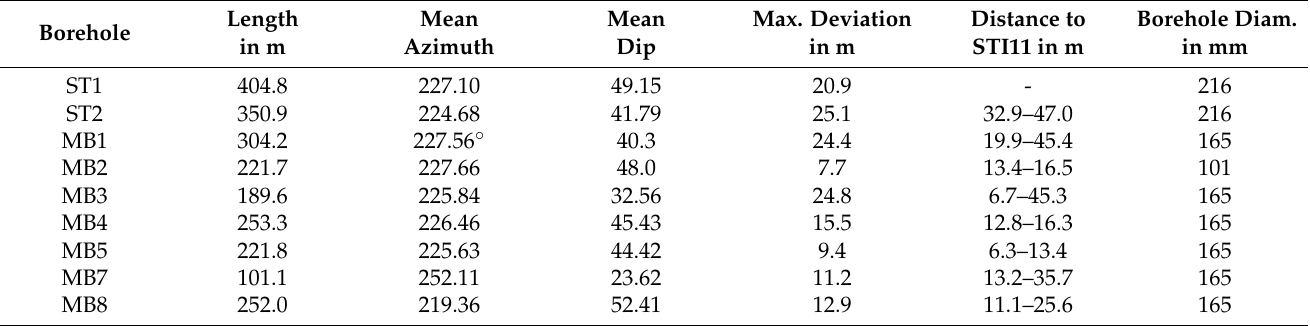
Table 3. Overview about boreholes drilled in the Bedretto Reservoir Project. Maximum deviation describes the deviation from straight trajectories. Borehole bending occurred as shown in Figure